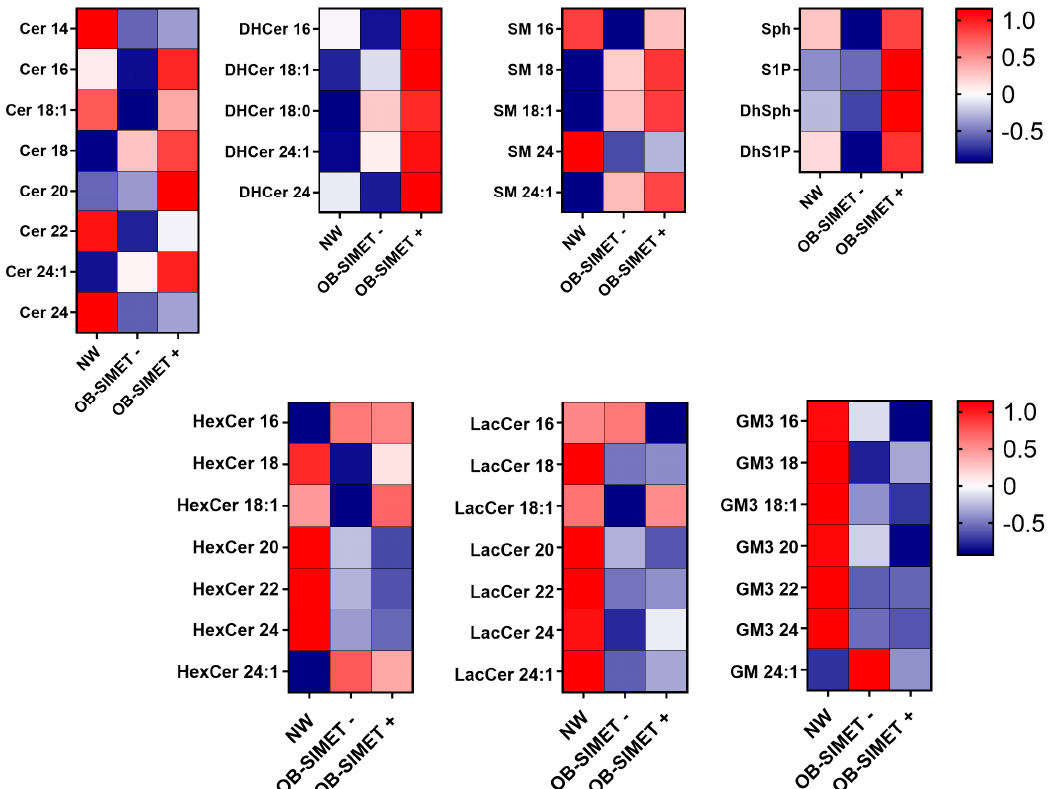
Figure 3. Visualization of sphingolipids as heatmaps. In particular, sphingolipid species were ordered according to their class—ceramides (Cer), dihydroceramides (DHCer), hexosyl-ceramides (HexCer), lactosyl-ceramides (LacCer), sphingomyelins (SM), GM3 ganglosides, and sphingoid bases—and visualized as heatmaps after transformation to z-values. The color-scale differentiates values as high (red), average (white), and low (blue).